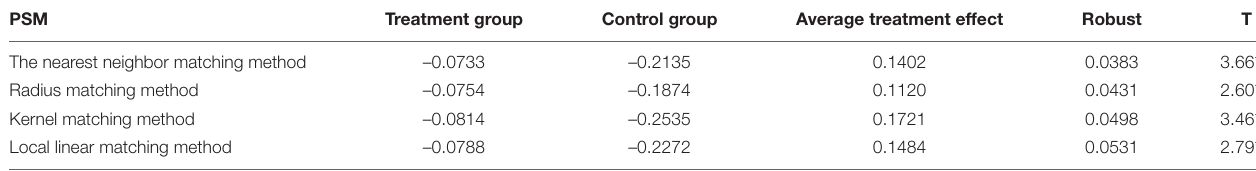
TABLE 6 | Propensity score matching estimation results.